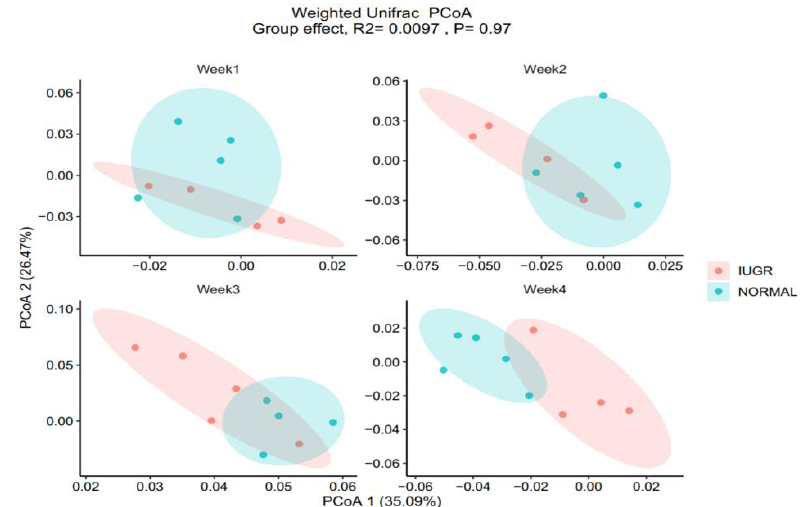
Figure 1. Gut microbiota (GM; as determined by V3 16S rRNA gene amplicon sequencing) of the intrauterine growth-restricted (IUGR) and normal piglet colon content for weeks 1, 2, 3, and 4. Each week, five IUGR and five normal piglets were sacrificed for the study: principal coordinate analysis (PCoA) plots of week 1 weighted Unifrac, p = 0.414; week 2 weighted Unifrac, p = 0.442; week 3 weighted Unifrac, p = 0.268; week 4 weighted Unifrac, p = 0.048.